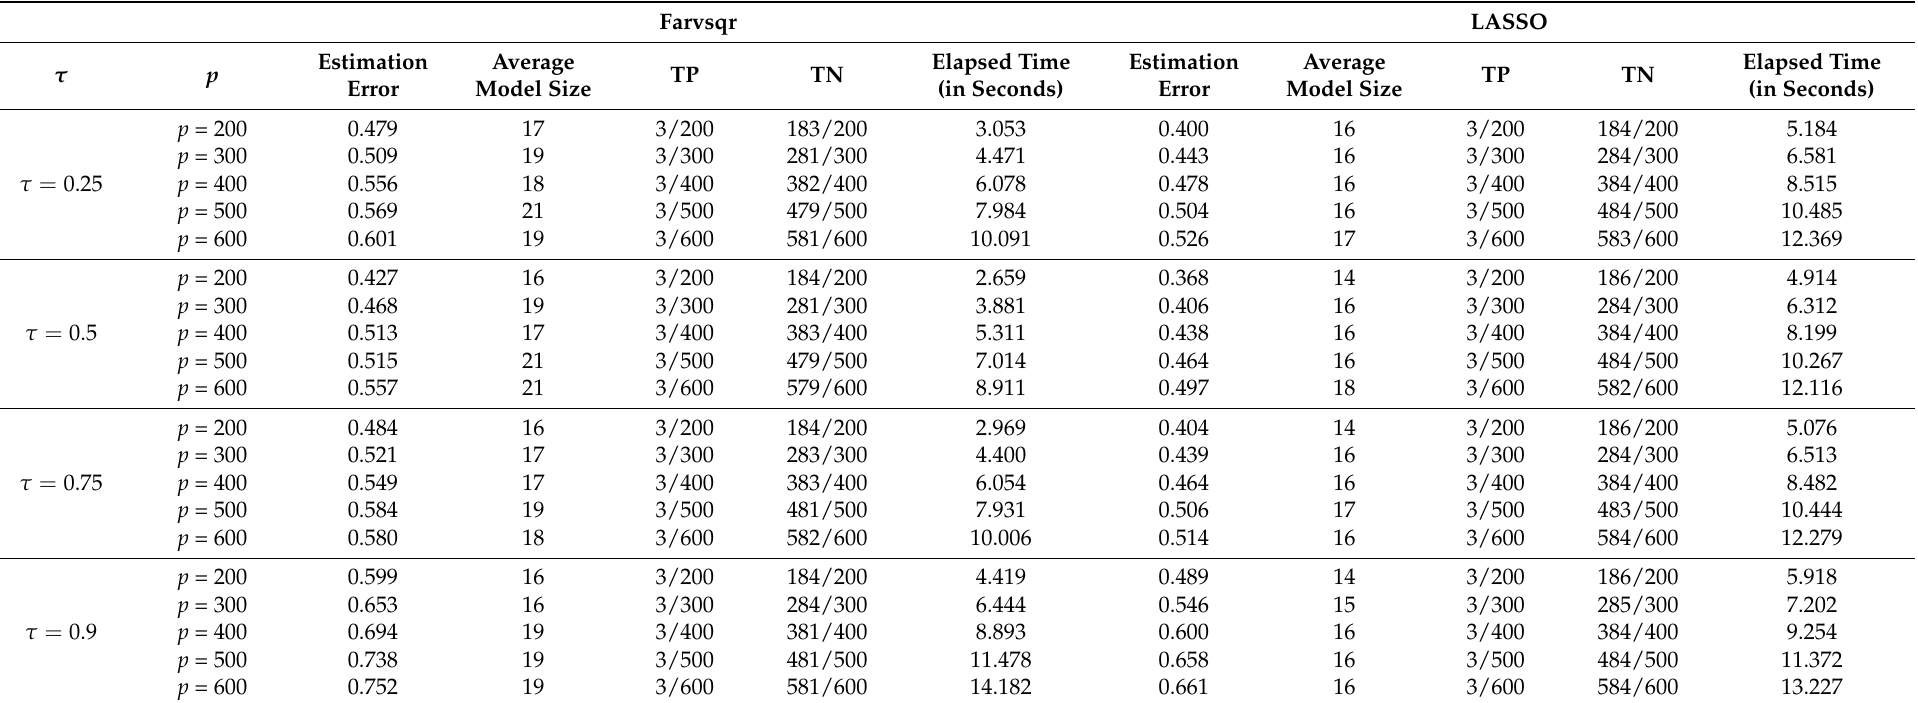
Table 12. The comparison for n = 1000,0.1 ∗ N ( 0,1 ) + 0.9 ∗ N ( 0,9 ) with the equal correlation. Farvsqr